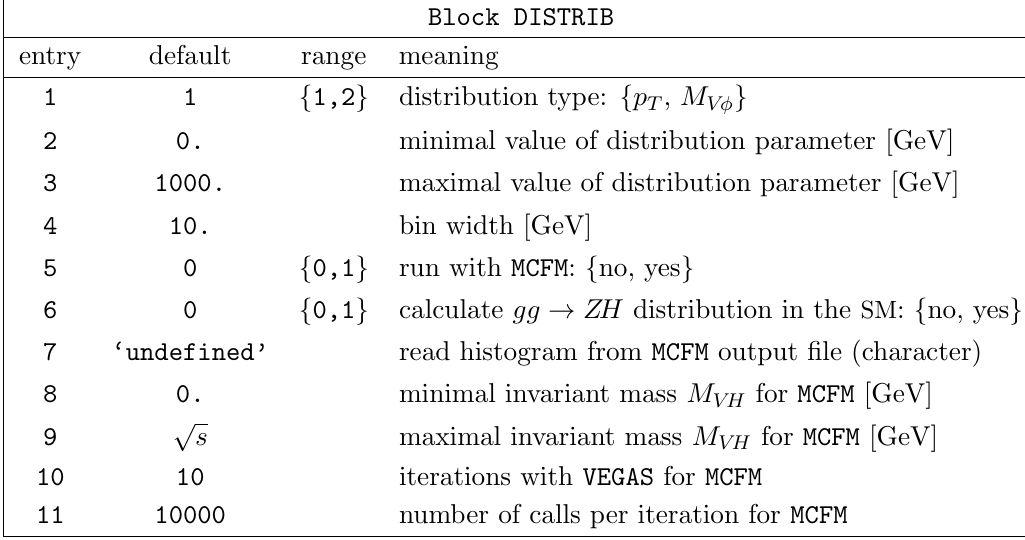
Table 10 . Setting the parameters for kinematical